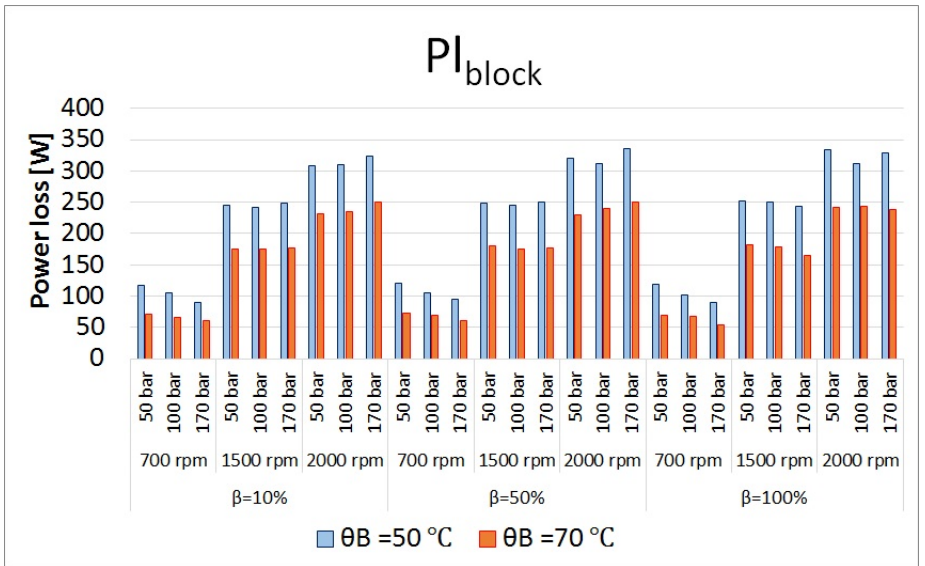
Figure 27. Total power losses in slipper/swash plate interface at different operating conditions.